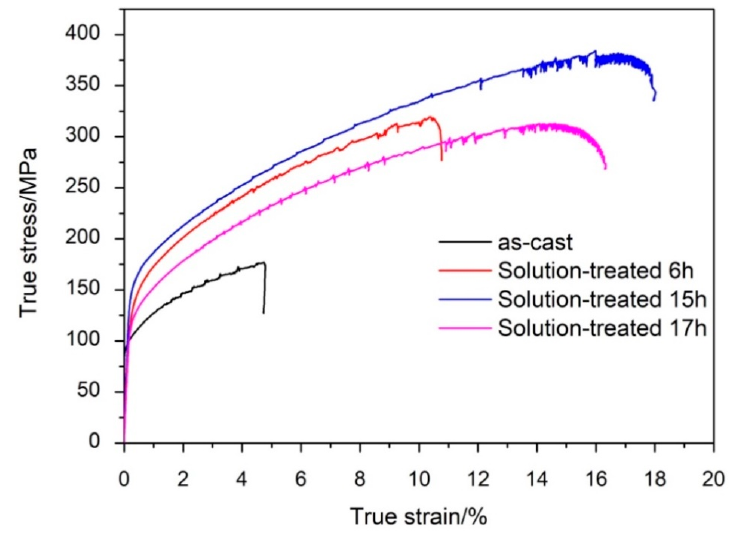
Figure 7. Stress–strain curves of squeeze-cast ZL205A after solution treatment at 538 °C.